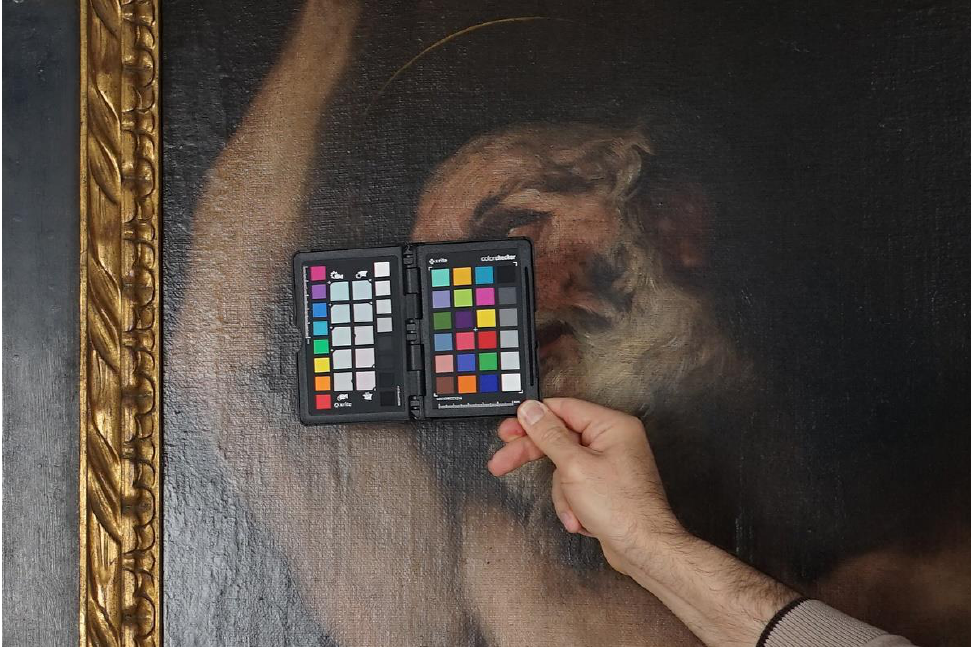
Figure 11. Reference picture with the X-Rite ColorChecker chart that will help to set the proper white balance and to create a specific colour profile for the lighting